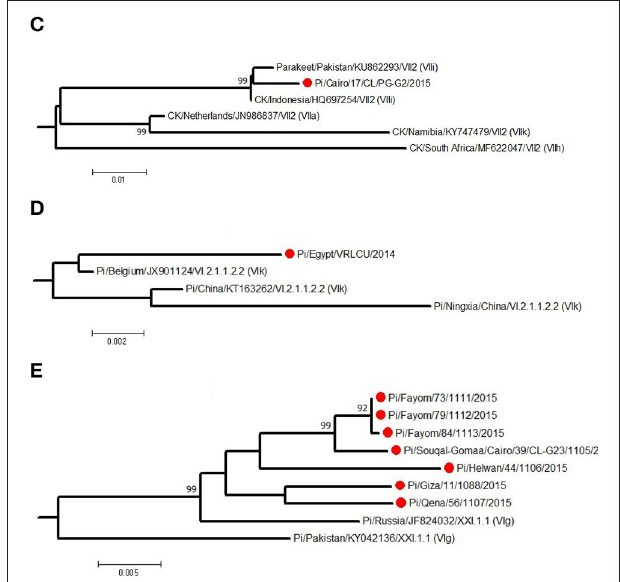
FIGURE 5 | The detailed full F protein gene-based phylogenetic tree of Egyptian Newcastle disease viruses (NDVs), representing various detected strains from different bird species, which belonged to different lineages, as (A) genotype II, (B) genotype VII.1.1, (C) genotype VII.2, (D) genotype VI.2.1.1.2.2, and (E) XXI.1.1. The construction of the tree was done by using the maximum likelihood (ML) method, general time-reversible model, and bootstrap values of 1,000 (17). Sequences from Egypt are labeled with a red